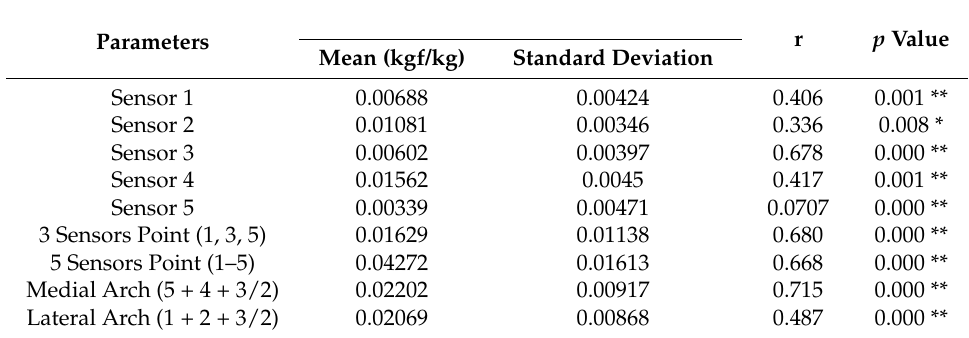
Table 2. Pearson correlation between the force sensor standing value and the ink-type AI value in the static